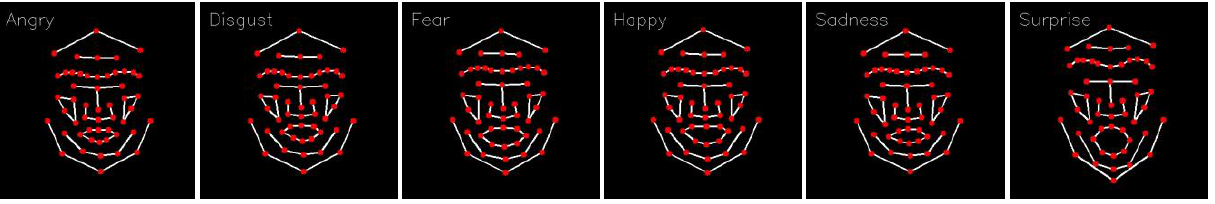
Figure 4. Maximum intensity frame of each facial expression